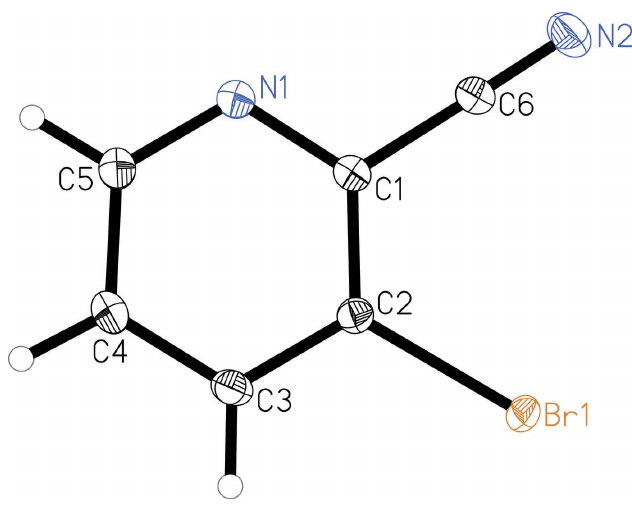
Figure 1 The molecular structure of the title compound with displacement ellipsoids drawn at the 30% probability level.